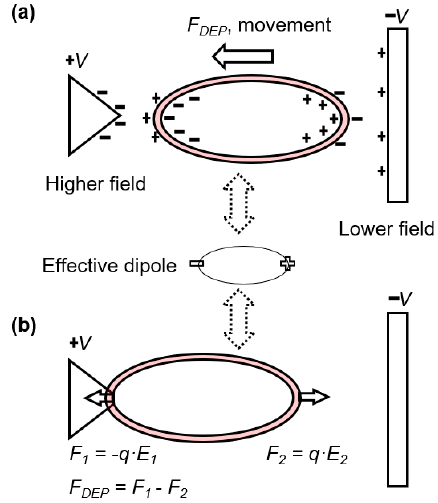
Figure 1. Schematic of electrostatics of biological cells in a non-uniform electric field. ( a ) The interactions between the electric field and the induced dipole charges at a thin ellipsoidal shell generate a net force, which acts to elongate the shell in the direction of electric field. The movement of the shell is known as dielectrophoresis. The direction of cell movement retains when the direction of field changes. ( b ) When the cell approaches the higher field strength and reaches an equilibrium state with no net movement, cell membrane is stretched uniaxially due to the force components in the opposite directions.